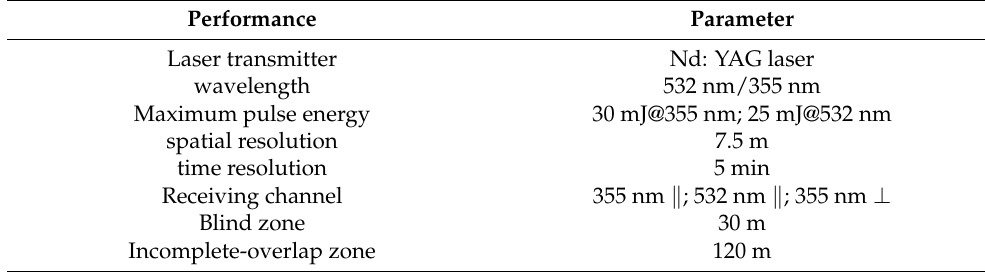
Table 1. Main performance of